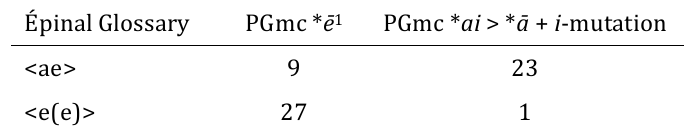
Table 6 : The spelling of * ē 1 not before nasals, and * ai + i- mutation with <ae> or <e(e)>; the contrast is highly significant in a Fisher’s Exact Test: p <